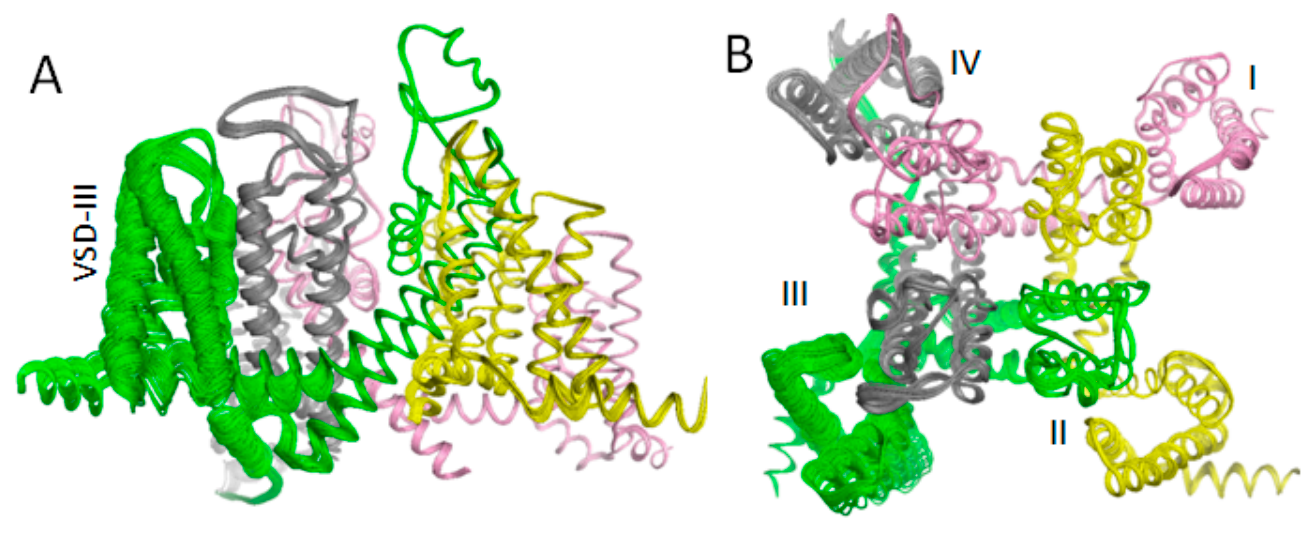
Figure 3. In silico deactivation of VSD III . Z-coordinates of C α atoms (z-axis coincides with the pore axis) in S4 III arginines were displaced from their positions in hNav1.5 in the cytoplasmic direction with the step of 0.5 Å. At each of the 21 steps the C α atoms were free to move within plane x0y but not to leave it, and the energy was MC-minimized until the last 200 energy minimizations did not improve the apparent global minimum found at the step. No other constraints were imposed. The entire displacements of the z-coordinates of arginines by 10.5 Å were approximately equal to those in the NavAb and NavAb/Nav1.7 experimental structures with up/down positions of VSDs. ( A , B ) Intra-membrane ( A ) and extracellular ( B ) views at the superposition of 21 MC-minimized structures. Repeat domains I, II, III and IV are pink, yellow, green, gray, respectively. Note that besides large perturbations in VSD III and IIIS4–S5, significant changes are seen in repeat domain IV, where S5 IV directly contacts S4 III and S4–S5 III wile S6 IV contacts S4–S5 III .